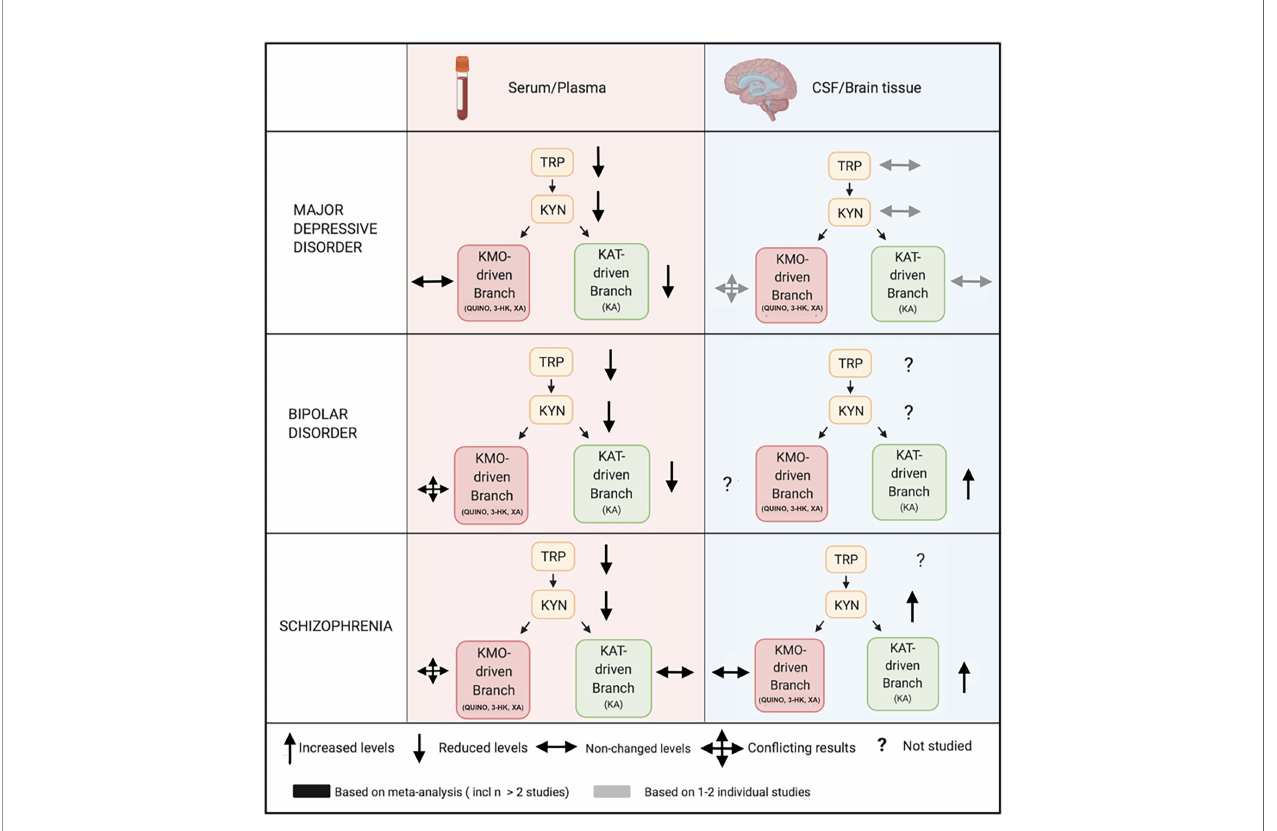
FIGURE 3 | Comparing peripheral (serum/plasma) and central (CSF/brain tissue) kynurenine pathway fi ndings in major psychiatric disorders. Legend: In mood disorders, peripheral studies demonstrate decreased measures of blood TRP, KYN and a downregulation of the KAT-driven branch in the periphery, which